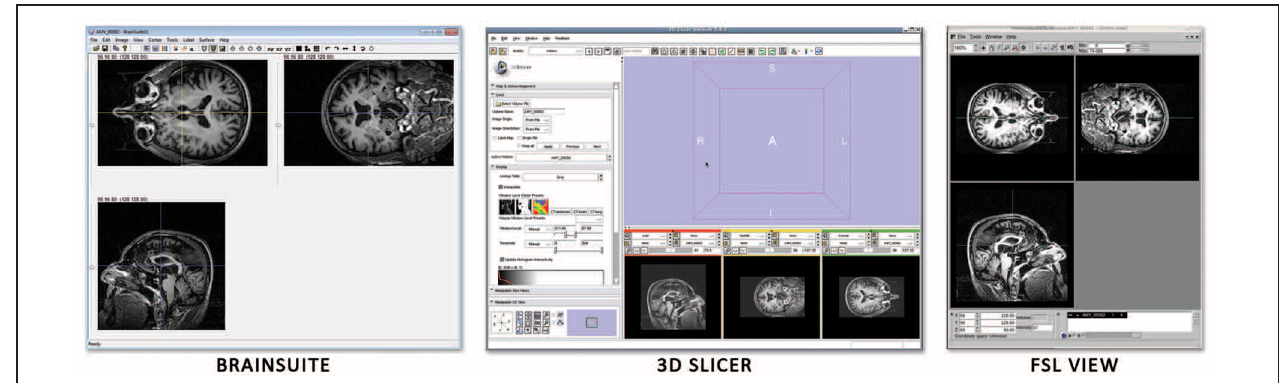
FIGURE 6 | Three image viewers display the same ANALYZE 7.5 file: (A) BrainSuite, (B) FSLView, (C) 3D Slicer. Without image markers it is difficult to deduce the subject’s right from the subject’s left and easy to get the two reversed when moving between